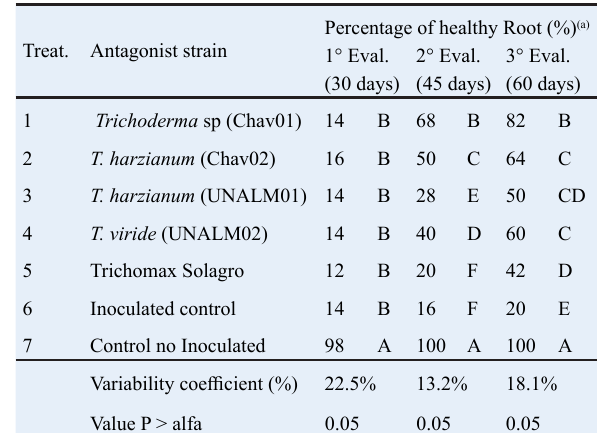
Table 3. Percentage of healthy roots in avocado seedlings inoculated with Phytophthora cinnamomi treated with different Trichoderma strains